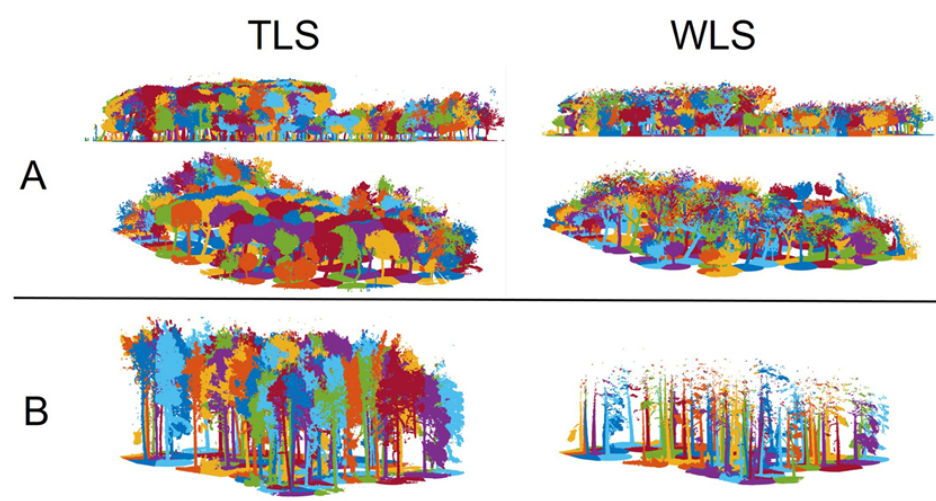
Figure 16. Individualized trees in random colors from test sites A and B (( up ) and ( down ), respectively).